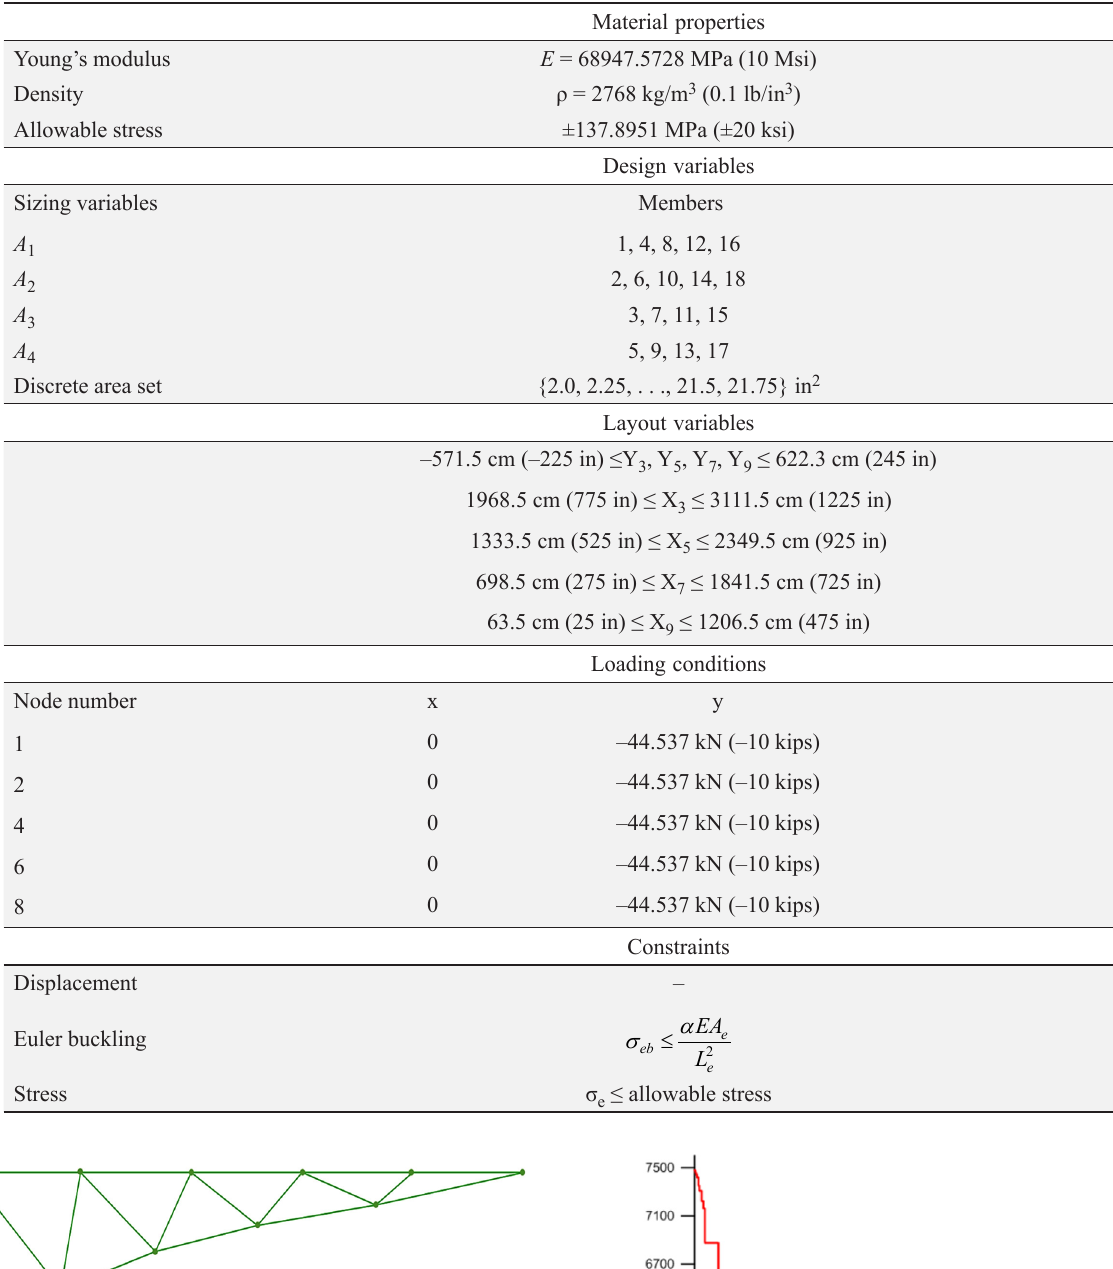
Table 3. Input data for the planar 18-bar truss problem